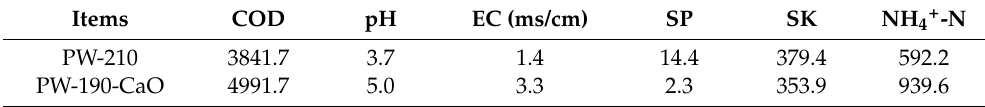
Table 6. Basic properties of PW